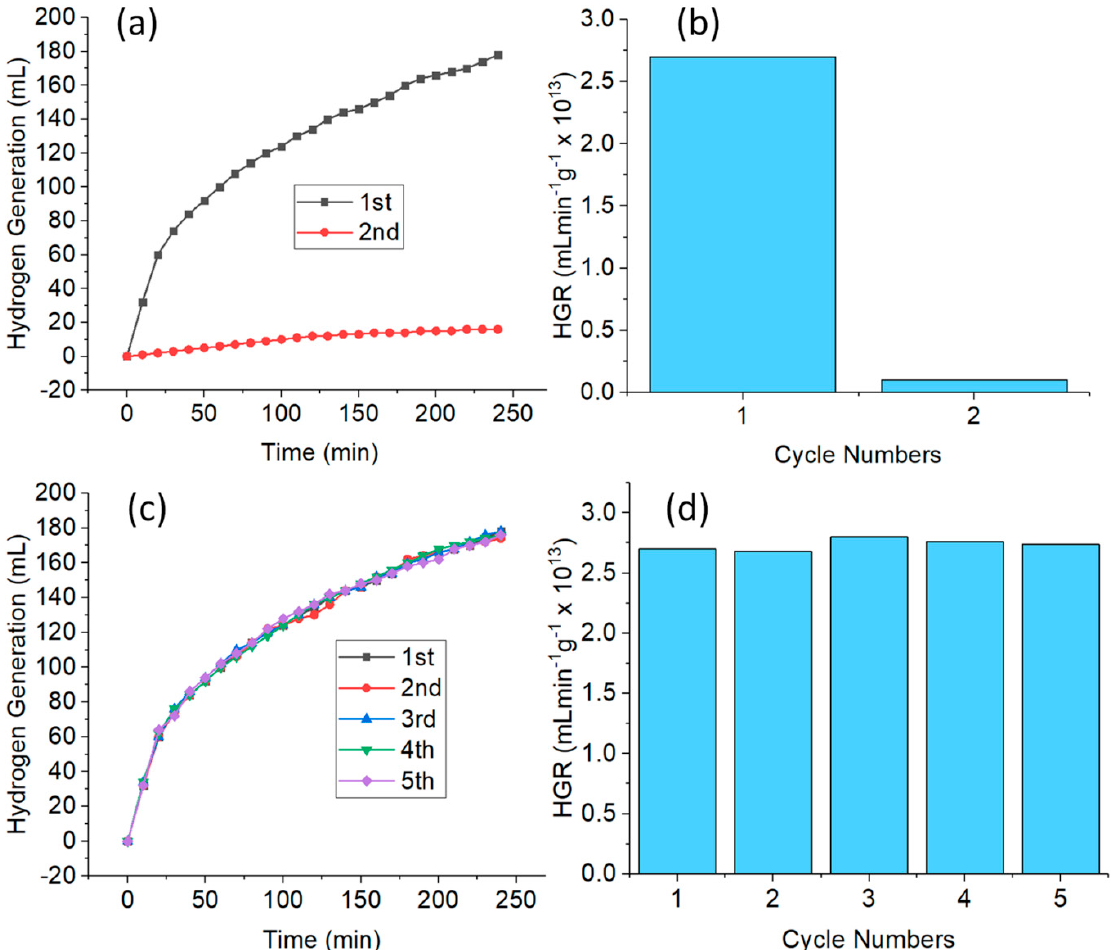
Figure 5. Plot of ( a ) H 2 generation versus time; and ( b ) HGR of the hydrolysis of NaBH 4 without retreatment of the CuNWs strips for two cycles, and ( c ) H 2 generation versus time; and ( d ) HGR of NaBH 4 with retreatment of the CuNWs using glacial acetic acid (GAA) in five consecutive cycles. (Conditions: CuNWs = 0.1 ng, 10 mL of [NaBH 4 ] = 1 wt%, pH = 12, and temperature = 298 K).